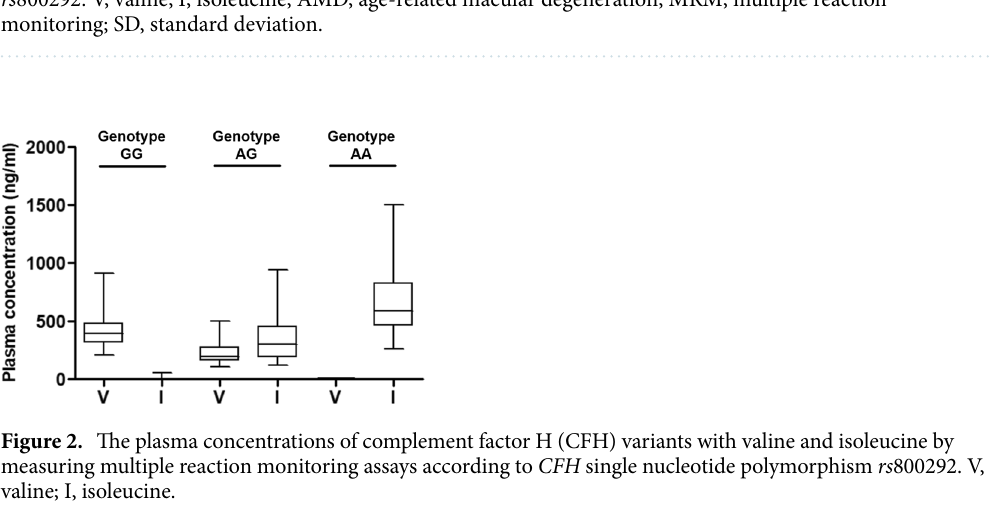
(Table 3, Fig. 4). The correlation between the plasma CFH valine/isoleucine (V/I) variant protein ratio and the genotypes of CFH SNP rs 800292 is depicted in Fig. 5. The average plasma CFH V/I ratio according to the genotypes of CFH SNP rs 800292 was as follows: GG, 606.906 ± 641.983 (7.854–4654.144); GA, 0.711 ± 0.138 (0.519–1.090); AA, 0.001 ± 0.002 (0.0001–0.009). We set the cut-off values as 1.09 and 0.0089 to match the plasma V/I ratio and SNP genotypes (GG: V/I ratio > 1.09; AG: 0.0089 ≤ V/I ratio ≤ 1.08; AA: V/I ratio < 0.0089). The distribution of